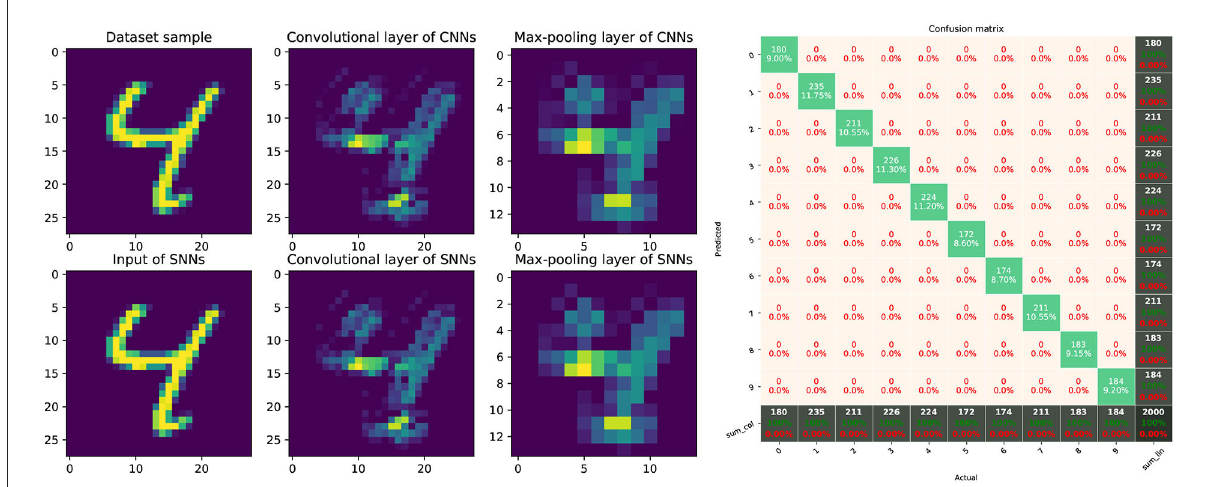
FIGURE16 Performance of SNN with ConvNet architecture. The left figure shows comparison of feature maps between ReLU-based ConvNet and LIF-SNN. The top figure shows the test image, feature map of convolutional layer, and feature map of max-pooling layer. The images in the bottom rows show the spikes count of output of LIF-SNN. The right figure shows the confusion matrix of LIF-SNN relative to the output of CNN.